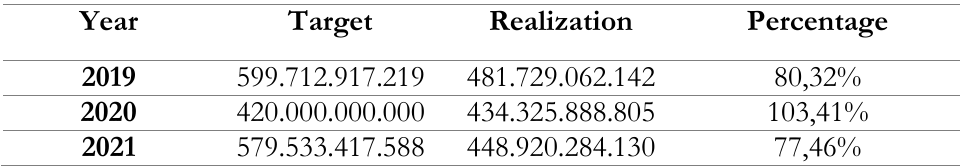
Table II Target and Realization of PBB-P2 Revenue for Bekasi City in